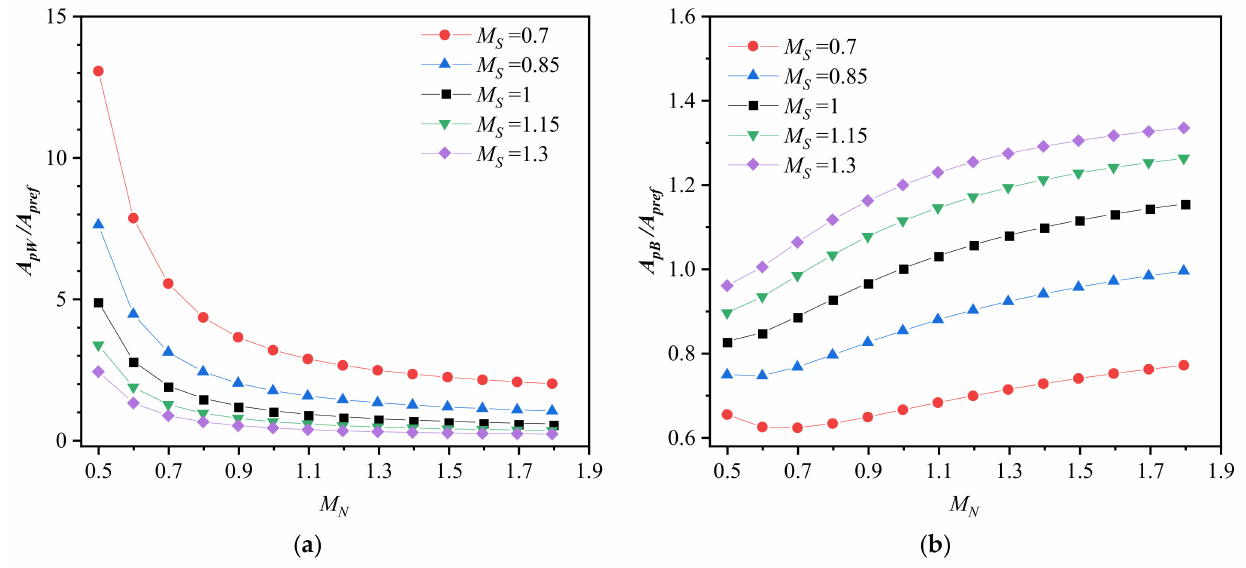
Figure 4. Plastic zone area. ( a ) Weld metal and ( b ) base